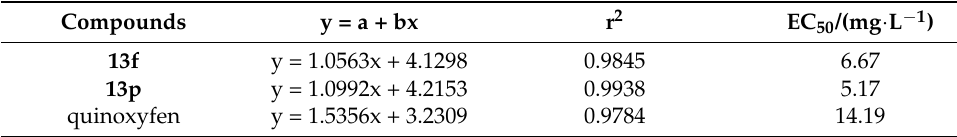
Table 3. EC 50 of compounds 13f , 13p and quinoxyfen to Sclerotinia sclerotiorum ( SS